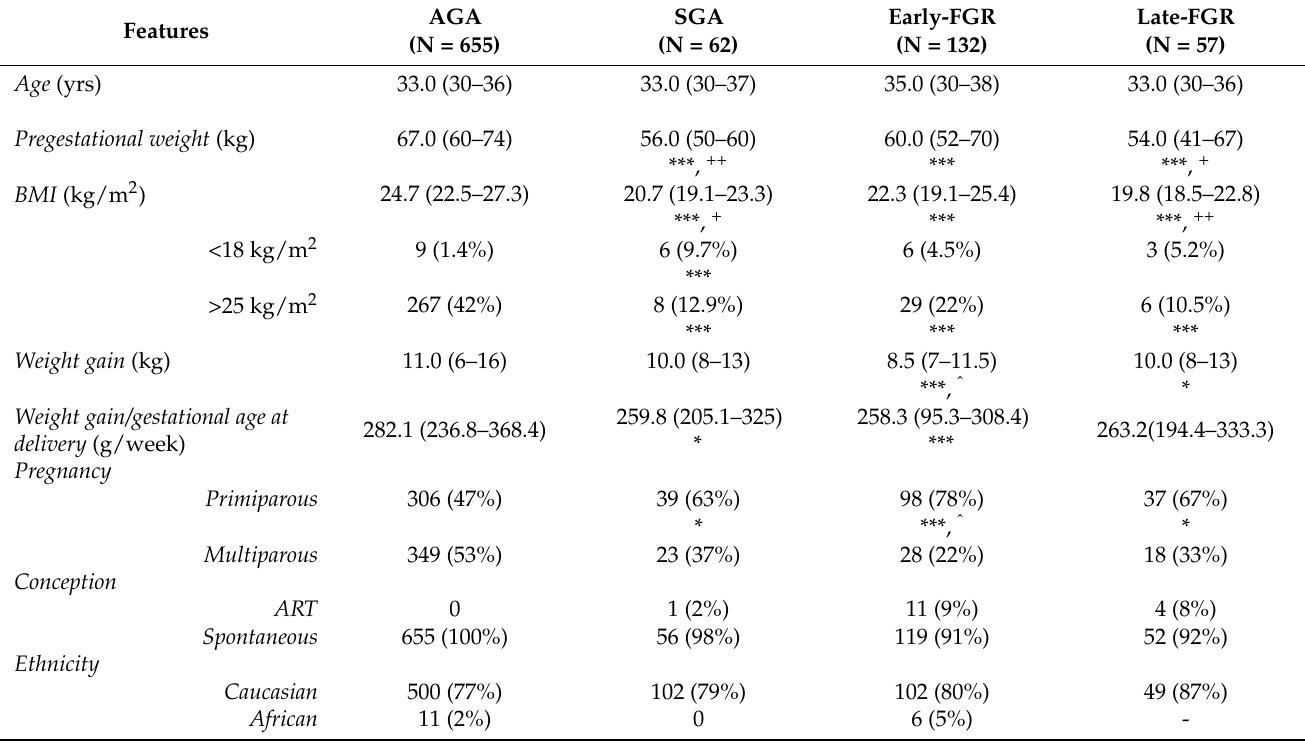
Table 1. Maternal